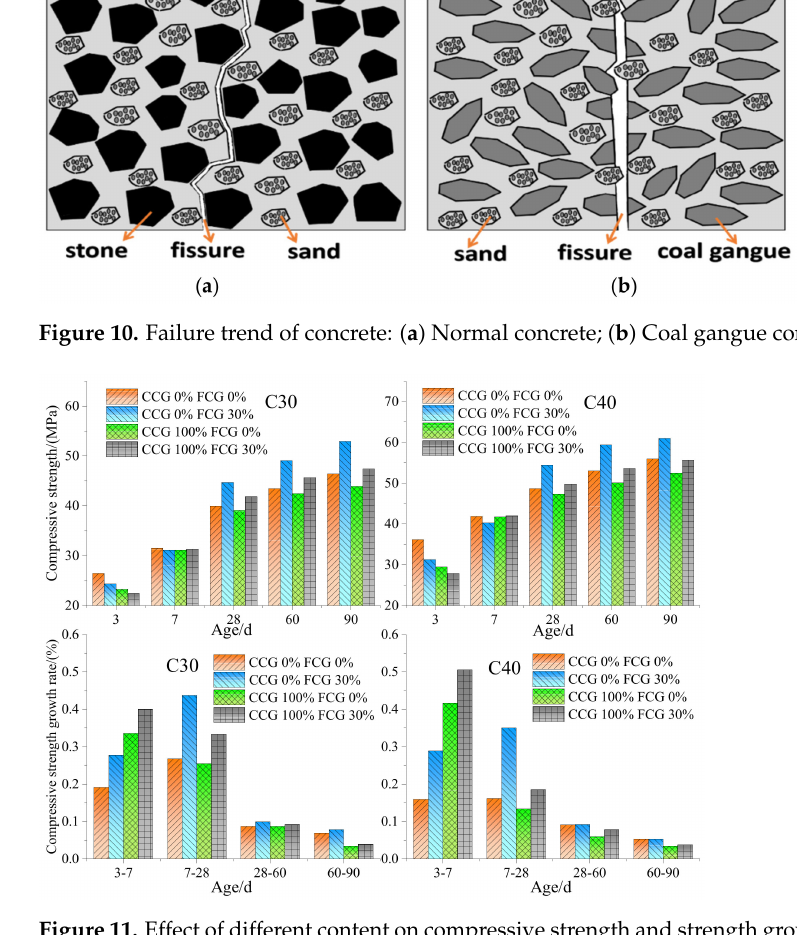
Figure 11. Effect of different content on compressive strength and strength growth rate of coal gangue concrete with different strength grades